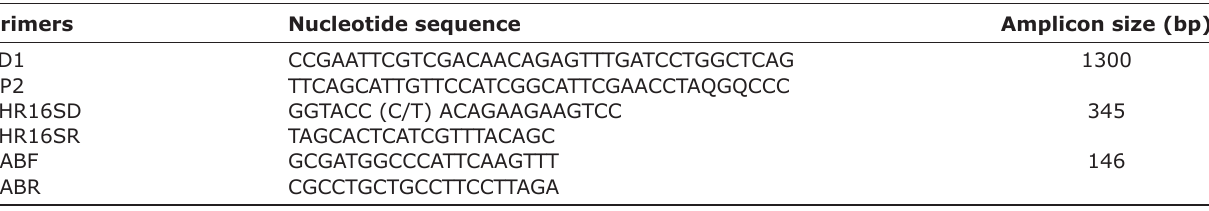
Table-1: Nucleotide primers for Anaplasma spp., Ehrlichia spp., and Babesia spp. detection.